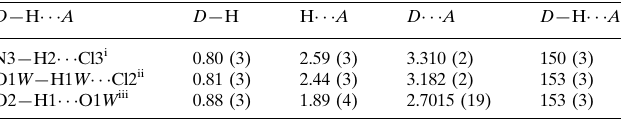
Hydrogen-bond geometry (A˚ , (cid:2)